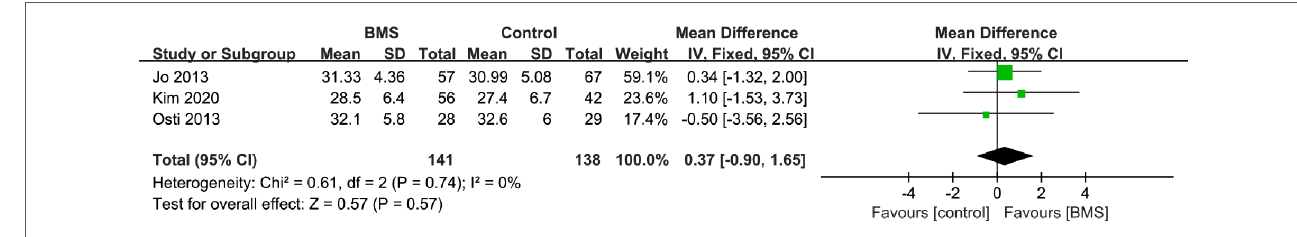
FIGURE 5 Forest plot comparing postoperative UCLA scores between the BMS and control groups.